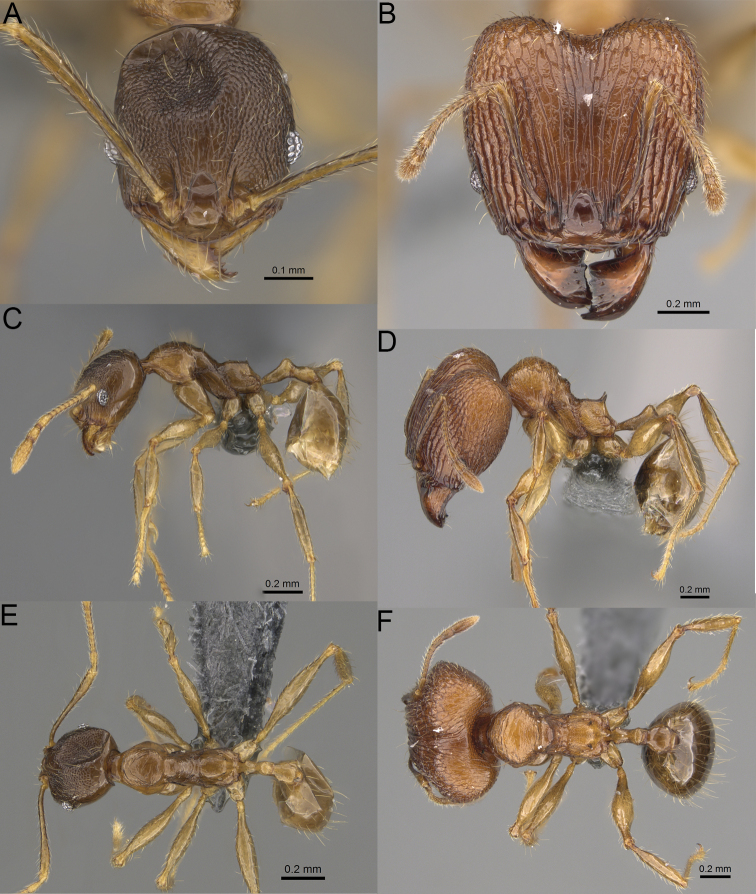
Pheidole
sava sp. nov., full-face view (A), profile (C), and dorsal view (E) of paratype minor worker (CASENT0923296) and full-face view (B), profile (D), and dorsal view (F) of holotype major worker (CASENT0808425).